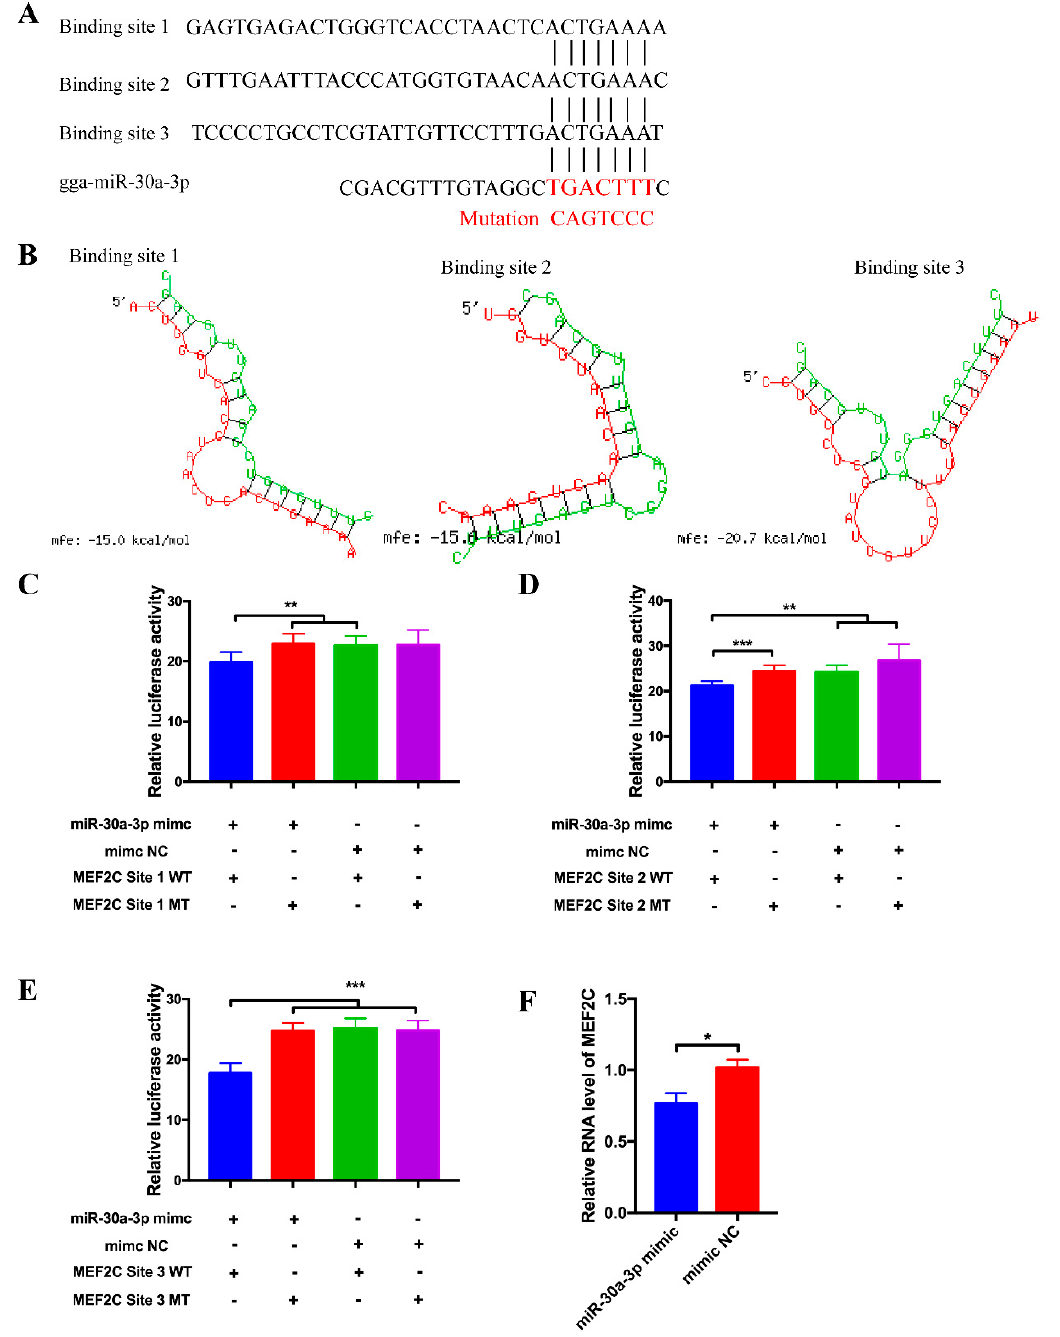
Figure 4. MEF2C is a target gene of miR-30a-3p. ( A ) The potential binding site sequence of miR-30a-3p on MEF2C. The seed sequences and mutant sequences were highlighted in red. ( B ) The potential interaction model between miR-30a-3p and MEF2C from RNAhybrid. ( C – E ) Luminescence was measured after co-transfecting wild type or mutant sequence of MEF2C with miR-30a-3p mimic (or mimic NC) in DF-1 cells. (n = 6). ( F ) The RNA level of MEF2C from miR-30a-3p mimic transfected CPMs. In all panels, values represent mean ± SEM from three independent experiments. * p < 0.05; ** p < 0.01; *** p < 0.001.